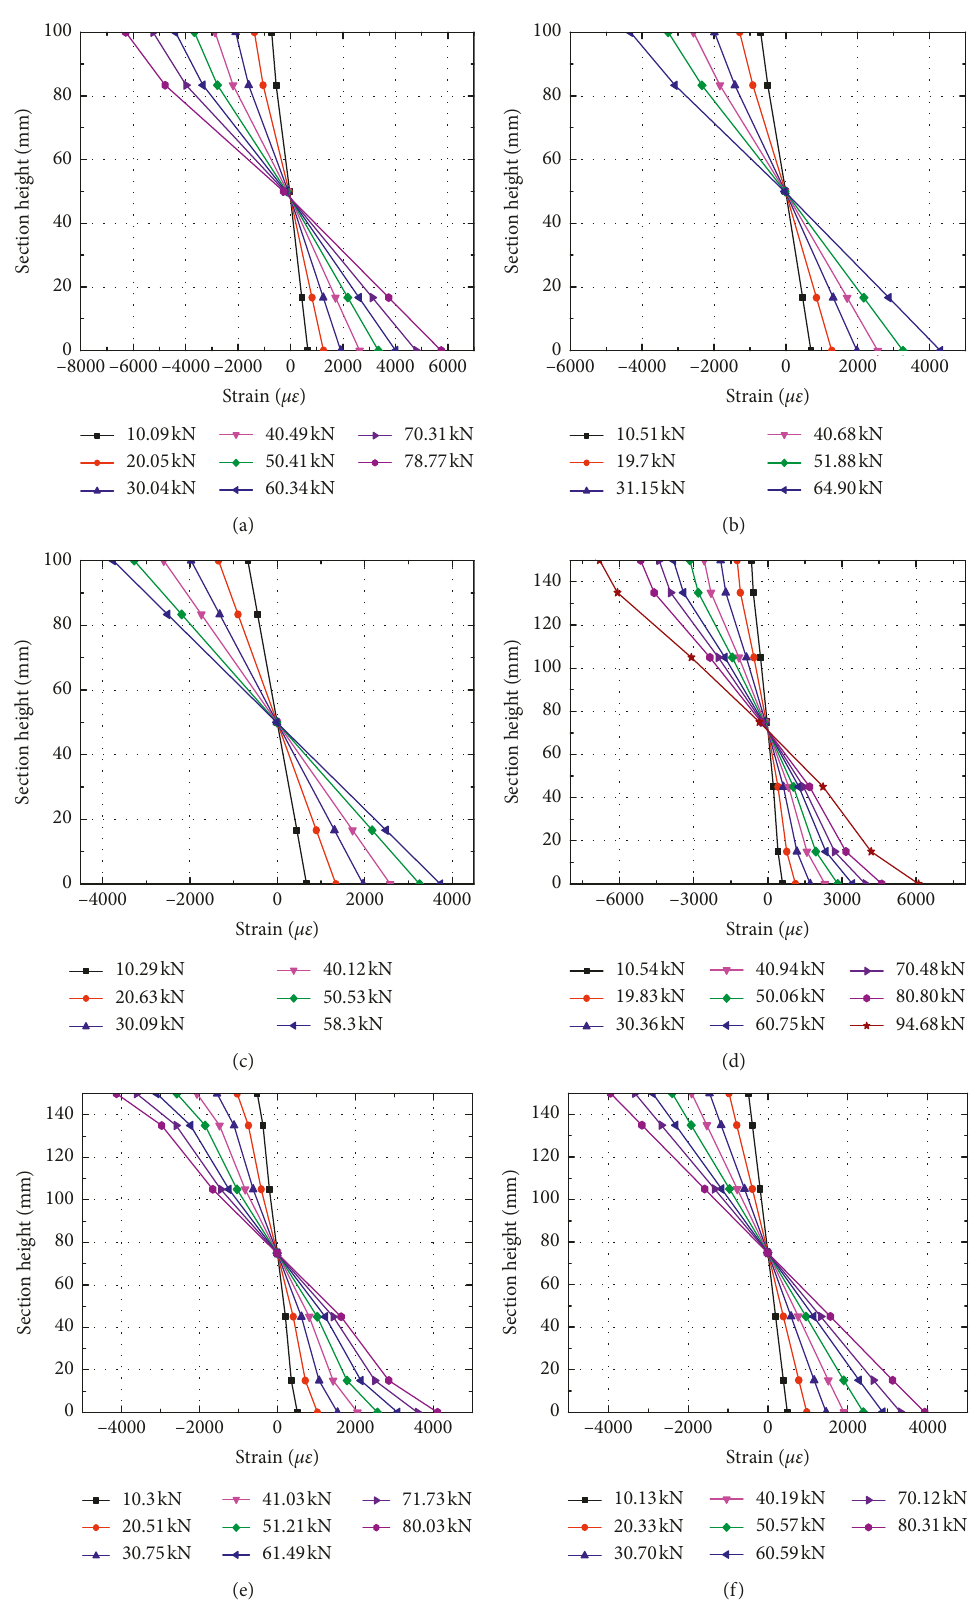
Figure 5: Strain profile of t midspan cross sections. (a) Specimen P1. (b) Specimen P2. (c) Specimen P3. (d) Specimen P4. (e) Specimen P5. (f) Specimen